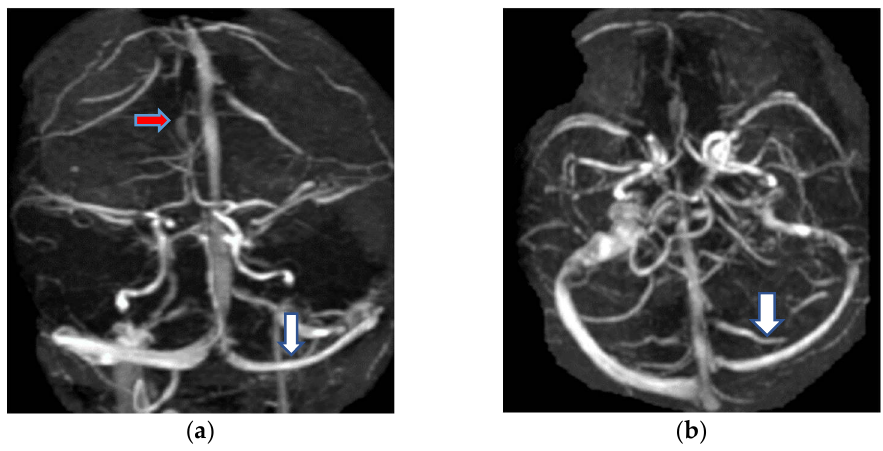
Figure 2. MR-venography 2D-TOF (2D-time of flight) in the coronal ( a ) and axial ( b ) plane reveals the permeabilization of the superior sagittal sinus (red arrow) and the left lateral sinus (white arrow) after six months of the onset.